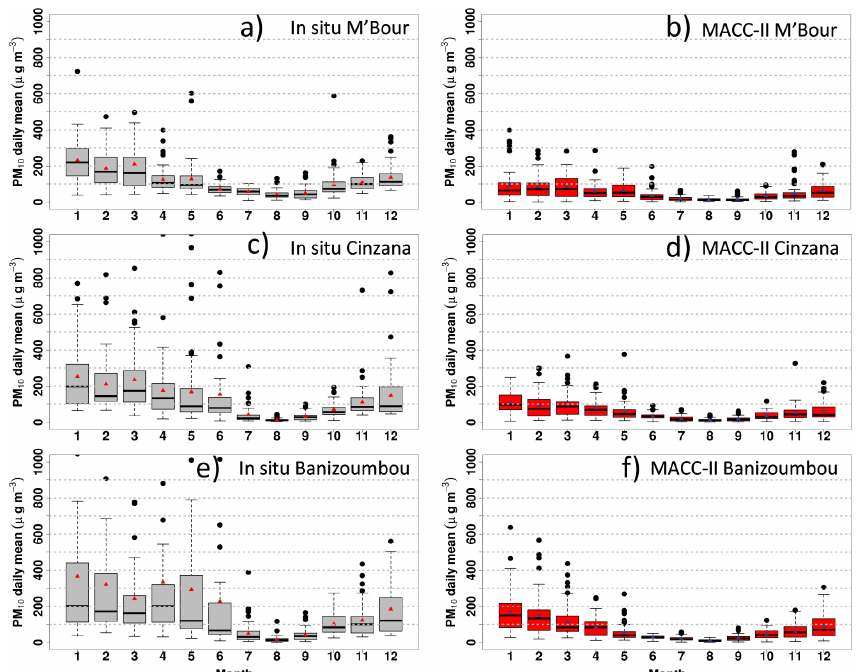
Figure 10. Monthly box-plots of surface dust concentration simulated by MACC-II and PM 10 observed by AMMA stations during the period 2007–2008 at M’Bour ( a and b ), Cinzana ( d and e ), and Banizoumbou ( e and f ). Box-plots indicate the following: the bottom and top of the box are the surface dust/PM 10 concentration 25th and 75th percentile, the band near the middle of the box is the 50th percentile (the median), and the triangle (red/blue) expresses the surface dust/PM 10 mean value. The ends of the whiskers represent the one SD above and below the mean of the surface dust/PM 10 data. Any data not included between the whiskers is plotted as an outlier with a